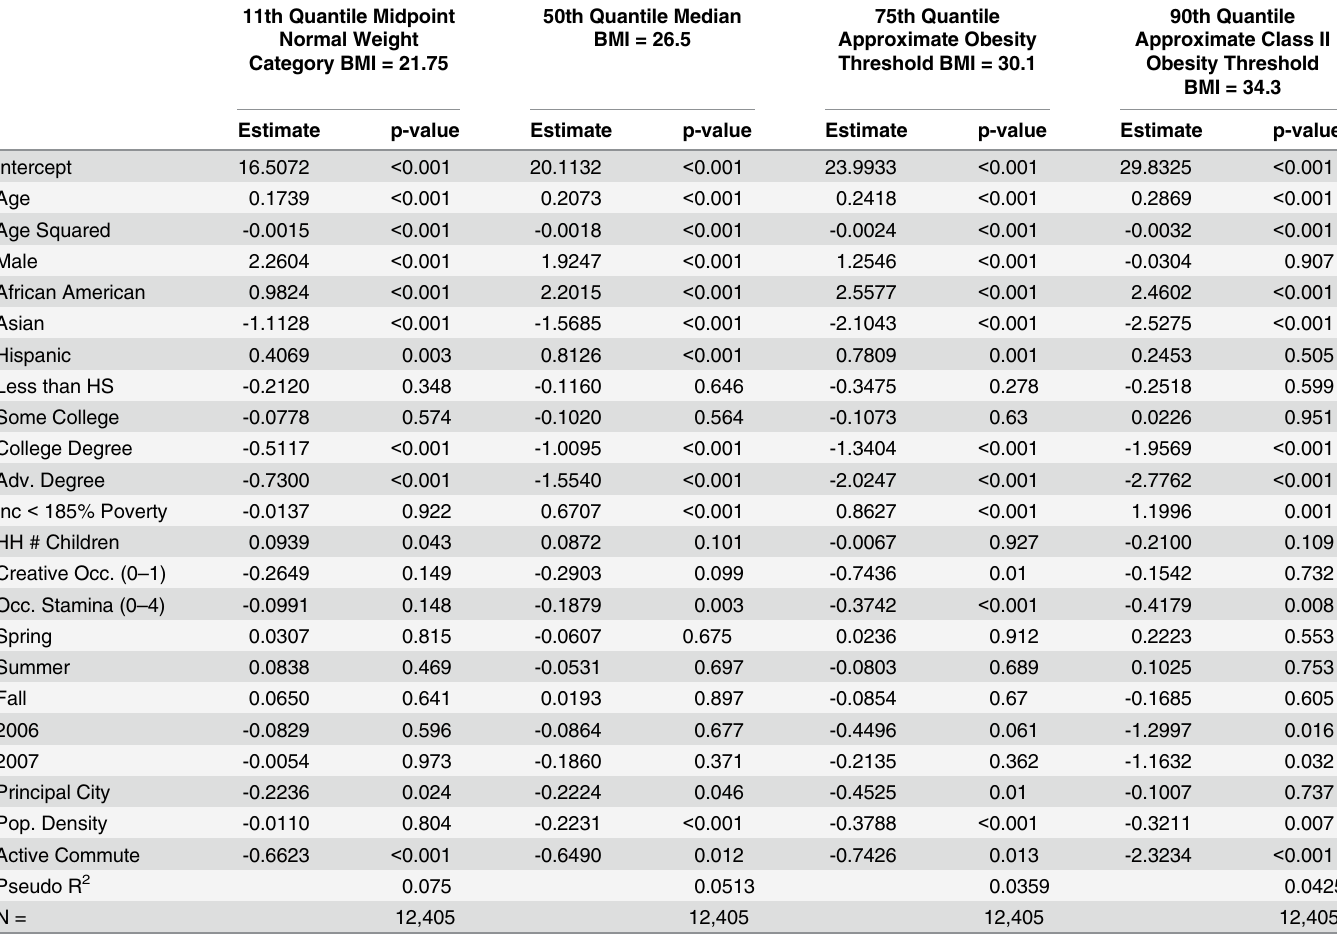
Table 5. Parameter Estimates from Simultaneous Quantile Regression on Body Mass